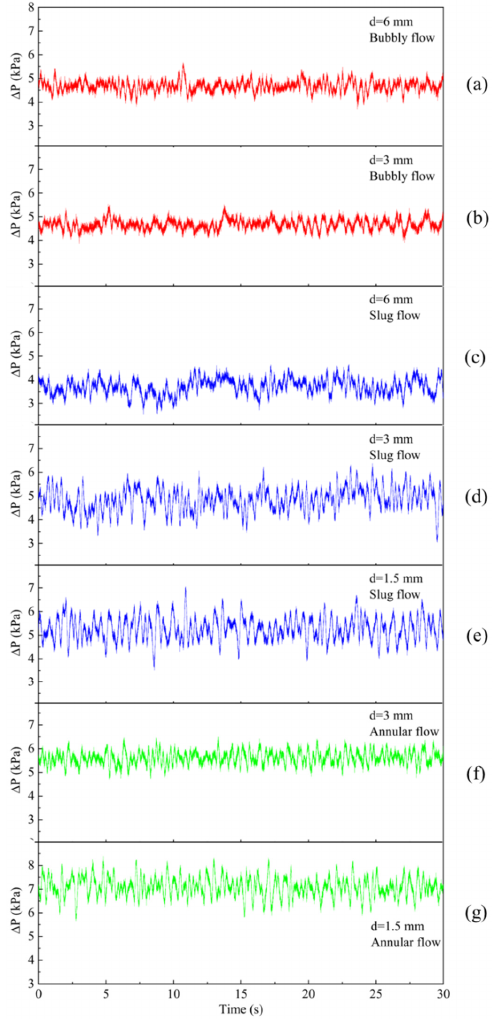
Figure 5. Diagram of differential pressure signals of typical flow patterns in different porous beds. ( a ). d = 6 mm, bubbly flow. ( b ). d = 3 mm, bubbly flow. ( c ). d = 6 mm, slug flow. ( d ). d = 3 mm, slug flow. ( e ). d = 1.5 mm, slug flow. ( f ). d = 3 mm, annular flow. ( g ). d = 1.5 mm, annular